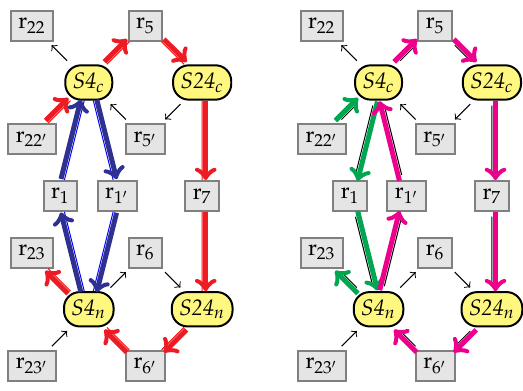
Figure 26. In red the elementary mode v red , in blue v blue , in green v green , and in magenta v magenta .